Question: Name the type of graph shown.
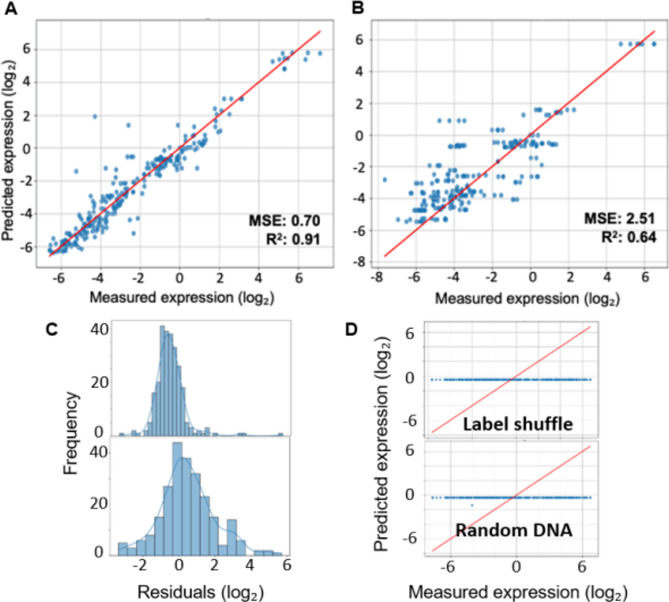
Answer: scatter